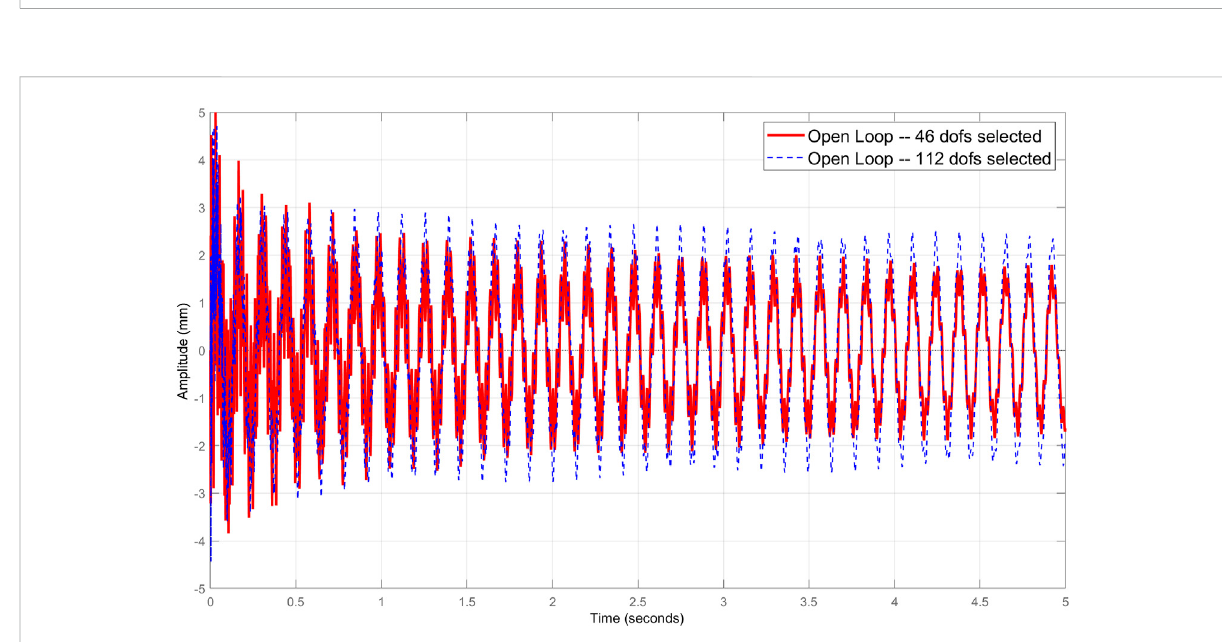
full model without control considering the selections of 46 and 112 dofs. In the full model case, Figure 13 shows the responses of the LQG-Kalman control under the same conditions as in Figure 12. Figure 14 presents a comparison in the reduced model case of LQR and LQG-Kalman controls considering only the selection of 46 dofs.